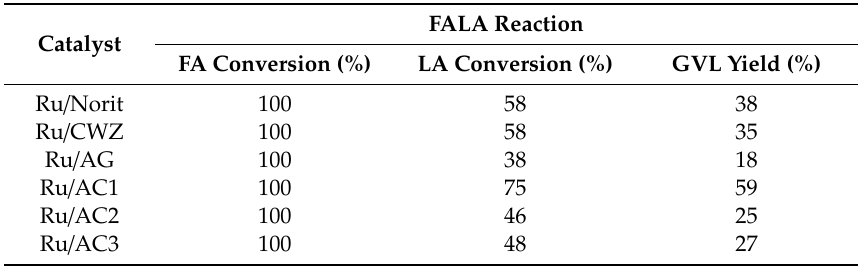
Table 5. Activity of ruthenium catalysts in simultaneous formic acid decomposition and levulinic acid hydrogenation